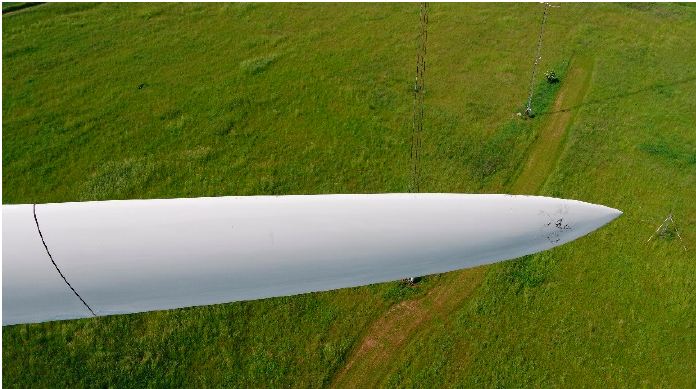
Figure 3. A collected blade image.